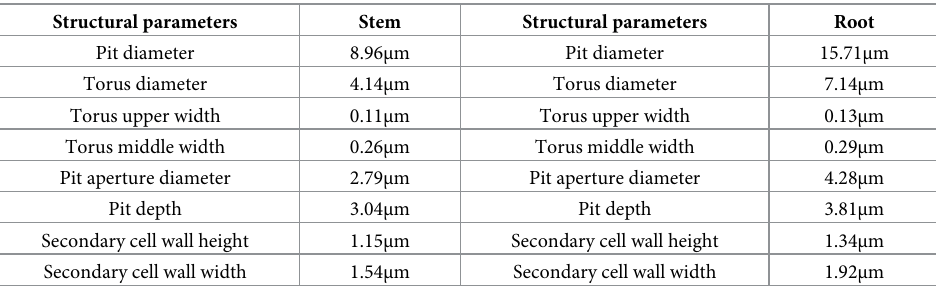
Table 2. Structural parameters of the TPS in roots and